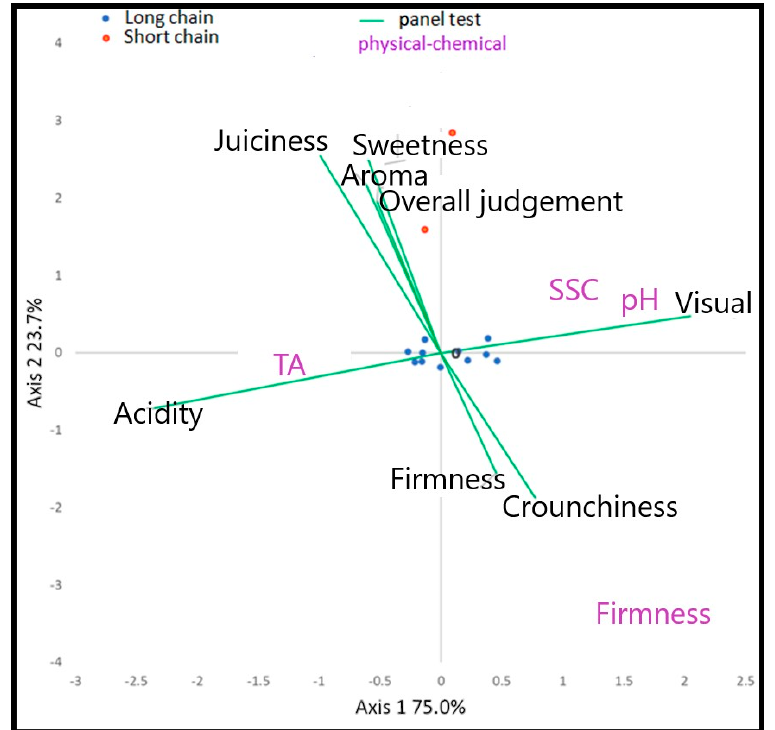
Figure 5. Triplot of the first two axes of the CANOCO conducted on physical–chemical (purple values) and panel test matrices (green vectors).